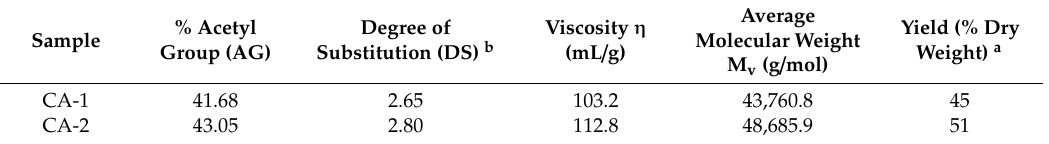
Table 2. DS, % AG and average molecular weight of as-prepared cellulose